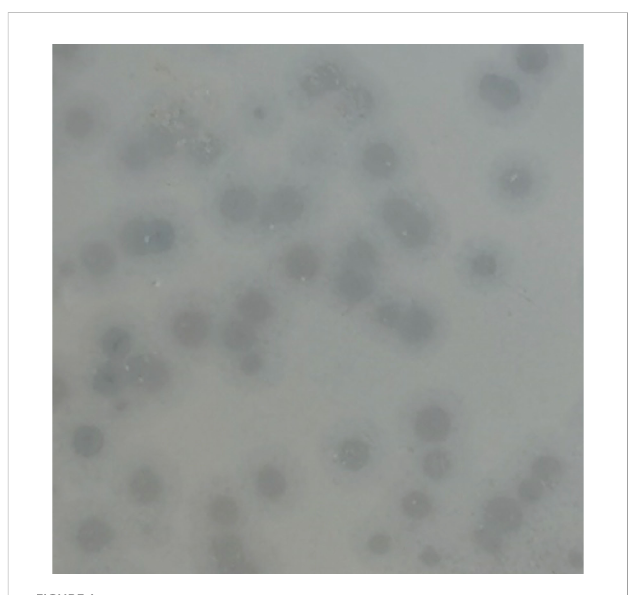
FIGURE 1 The plaques of the Vibrio phage vB_VhaP_PG11 on the lawn of host